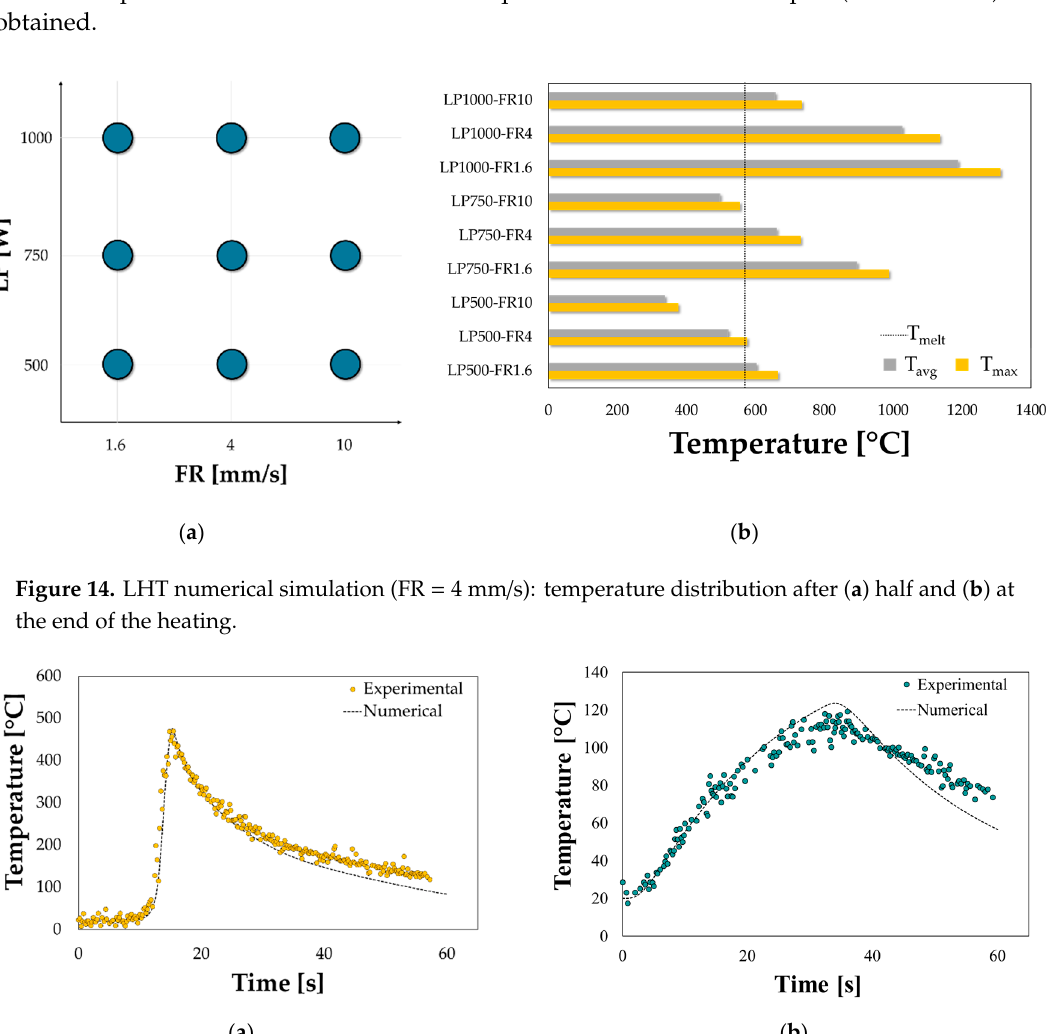
Figure 15. LHT of the circular blank: numerical vs. experimental comparison at the ( a ) thermocouple 1 (TC1) and ( b ) TC2 locations.